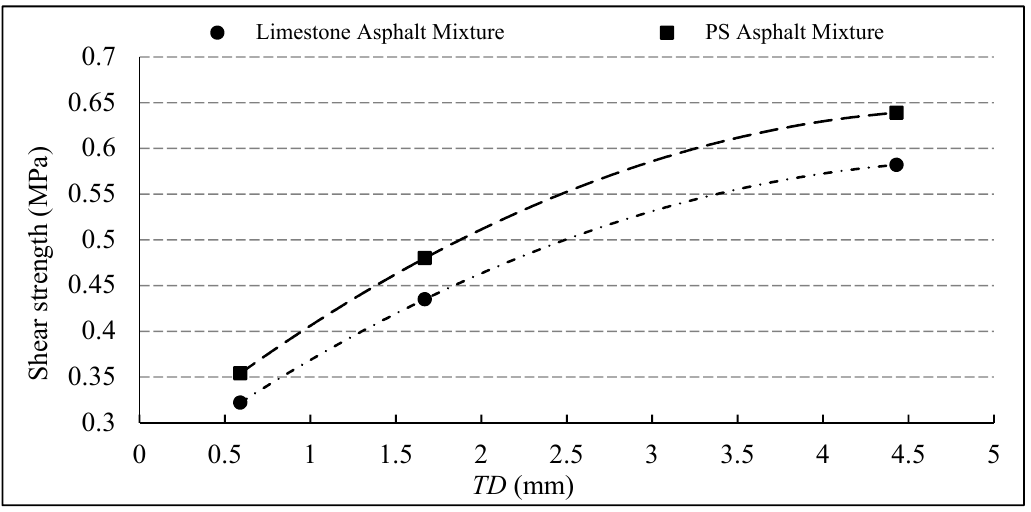
Table 4. Interlaminar shear strength of different waterproof and cohesive materials.